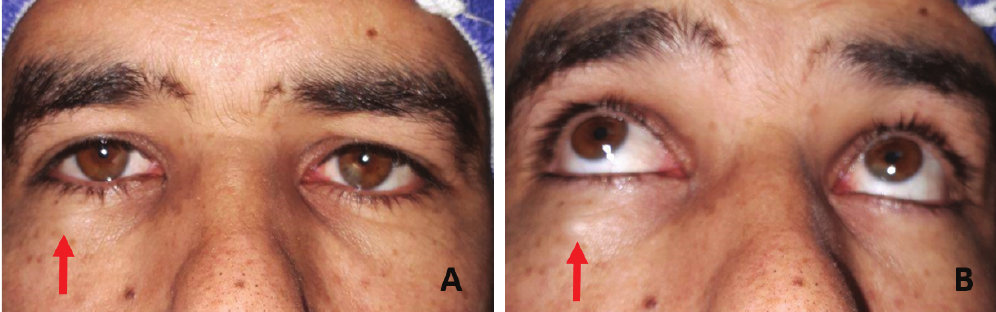
Figure 1. Clinical photography of the patient showing a nodular subcutaneous mass about 1 cm below the right lower lid margin which is more prominent in the upward gaze and skin depigmentation overlying the lesion. (Arrow shows the lesion) (A) Primary position. (B) Upward gaze.